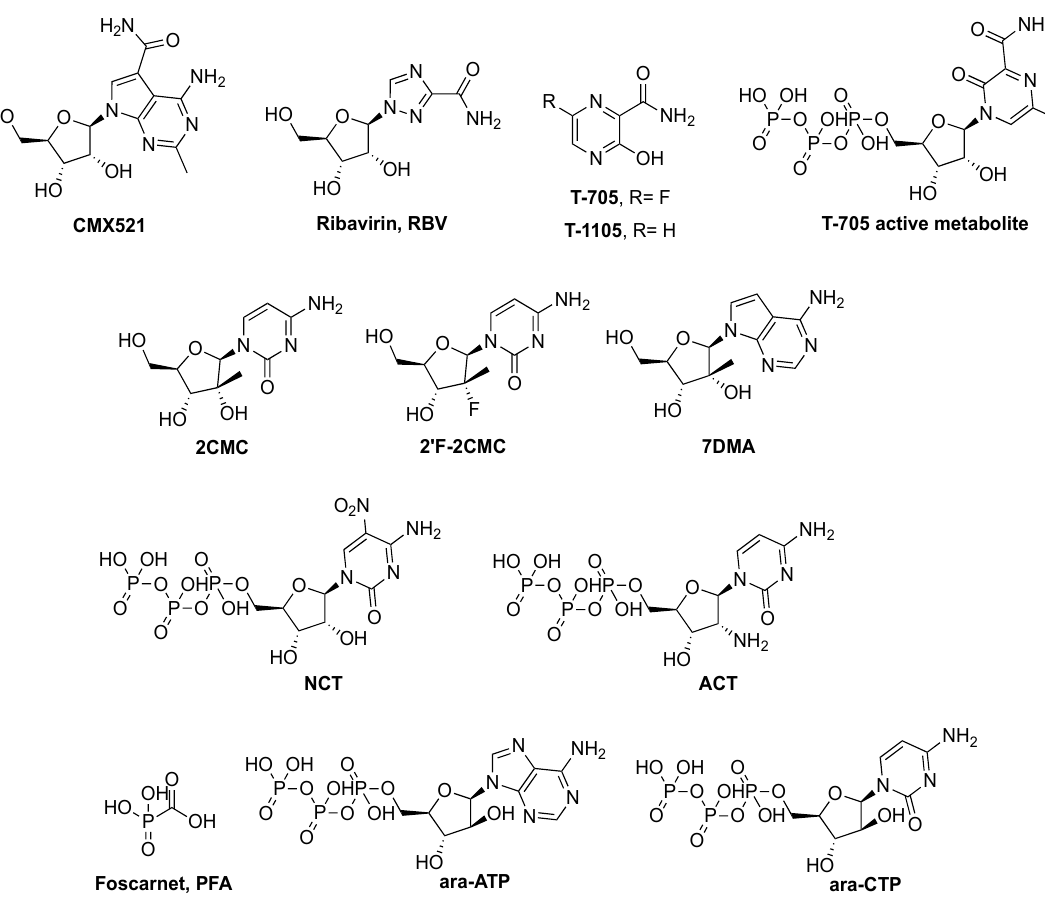
Figure 6. Structure of reported nucleoside analogues (or pyrophosphate mimics) inhibiting the RdRps of caliciviruses or rotaviruses.